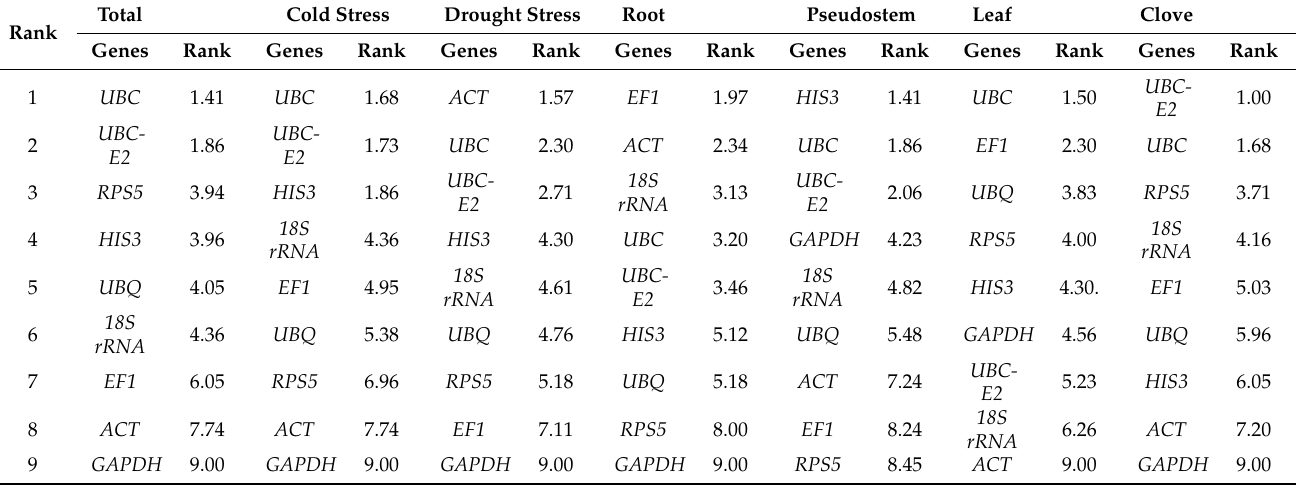
Table 4. Stability values of nine candidate reference genes in different treatments and tissues in